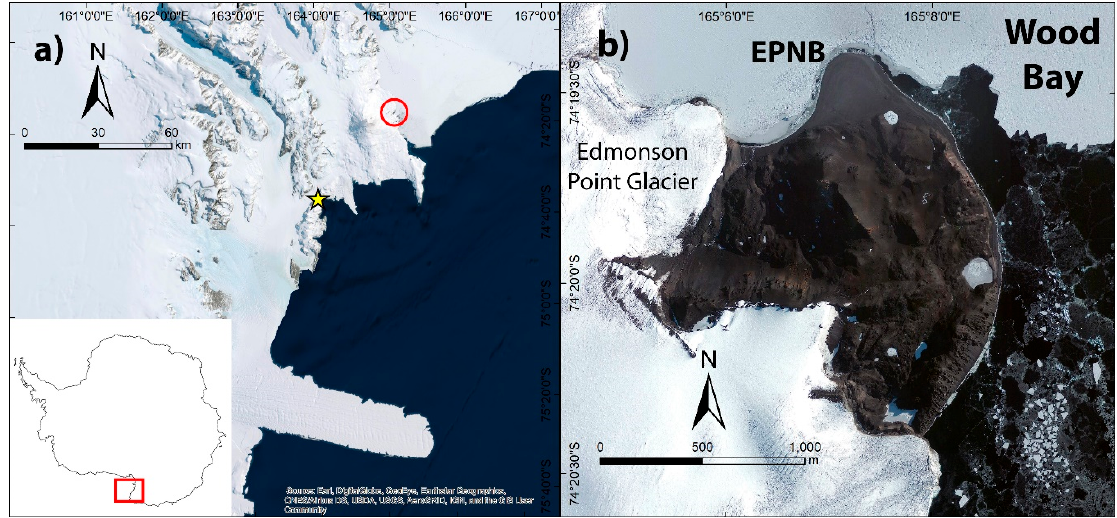
Figure 1. Study area: ( a ) Victoria Land (red square) and Edmonson Point location (red circle) next to Mt. Melbourne, ( b ) Edmonson point area and Edmonson Point North Beach (EPNB) position. Yellow star indicates Maria AWS.